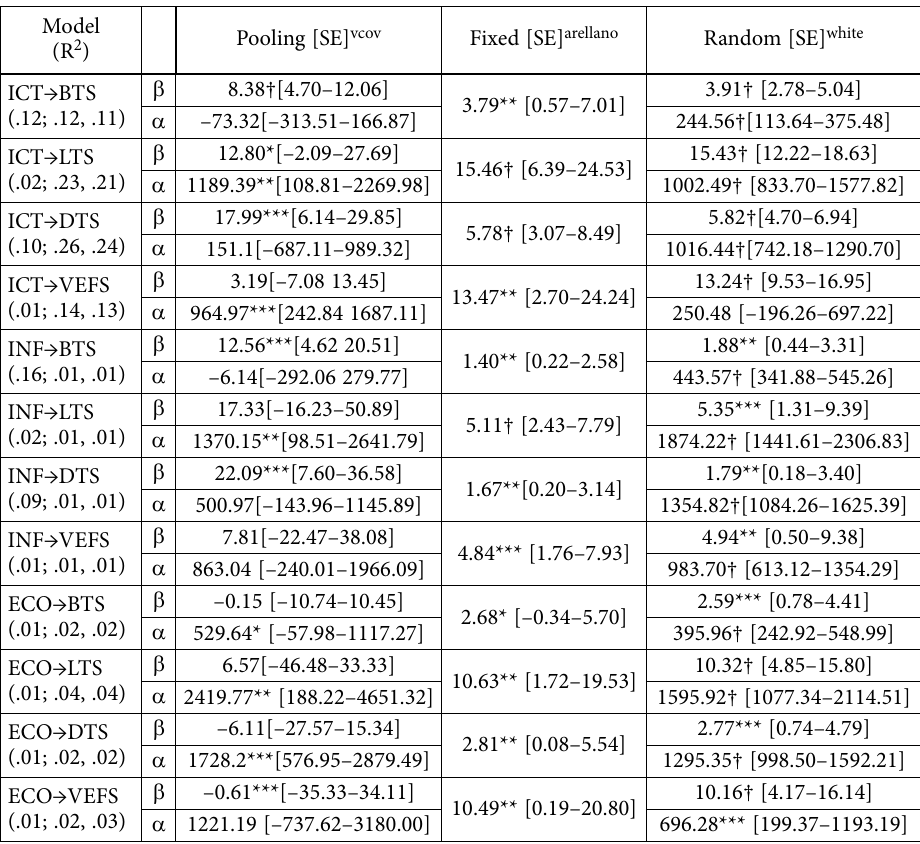
Table 6. Regression analysis